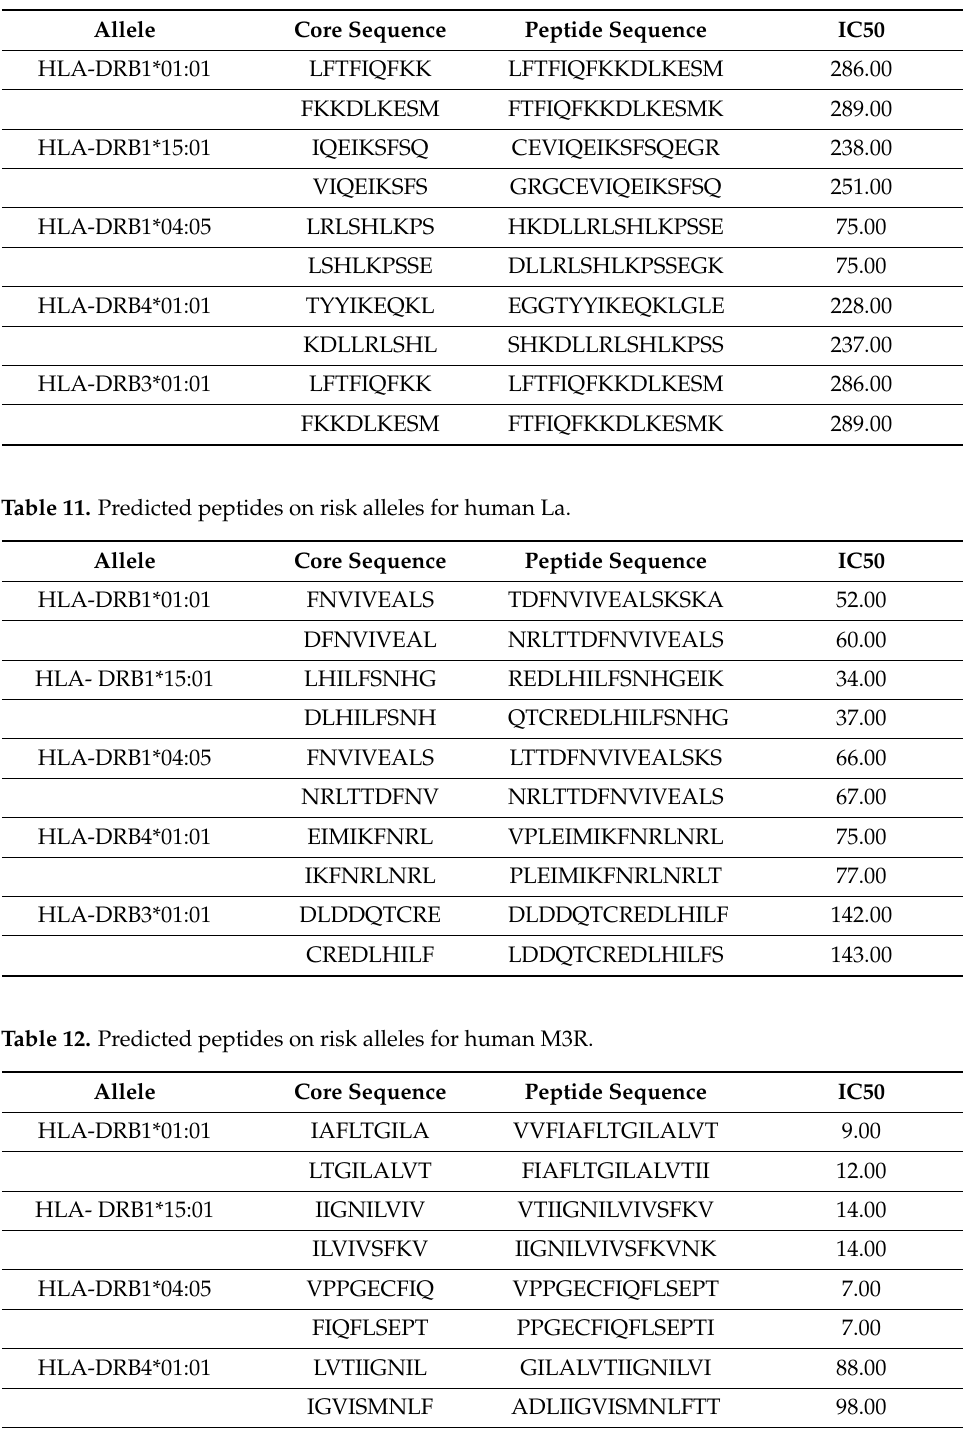
Table 10. Predicted peptides on risk alleles for human Ro60.